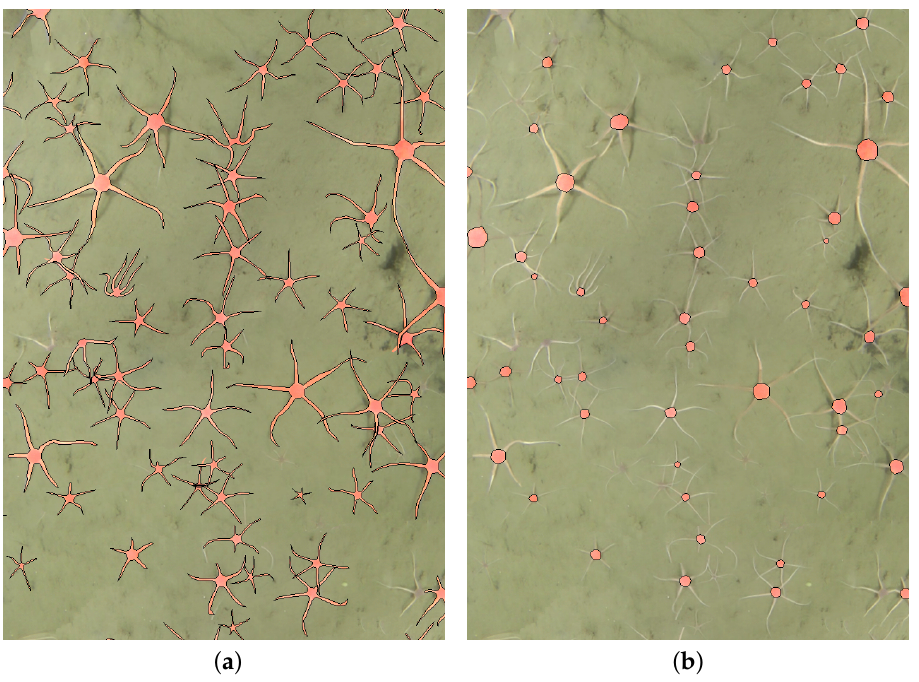
Figure 2. Annotation variants considered when preparing seabed mosaics for the semantic segmen- tation task. ( a ) Full shape annotation. ( b ) Disc